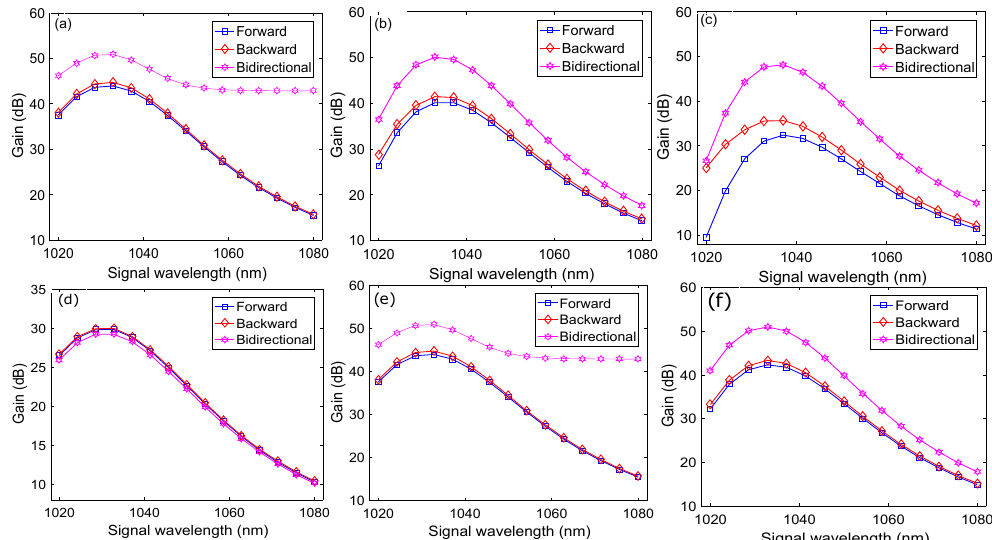
Figure 3. Gain optimization for performance benchmarking of the YDFA under different pumping configurations: ( a ) L = 2.5 m, 50 × 10 24 m − 3 ; ( b ) L = 5 m, 50 × 10 24 m − 3 ; ( c ) L = 7.5 m, 50 × 10 24 m − 3 ; ( d ) 25 × 10 24 m − 3 , L = 2.5 m; ( e ) 50 × 10 24 m − 3 , L = 2.5 m; ( f ) 75 × 10 24 m − 3 , L = 2.5